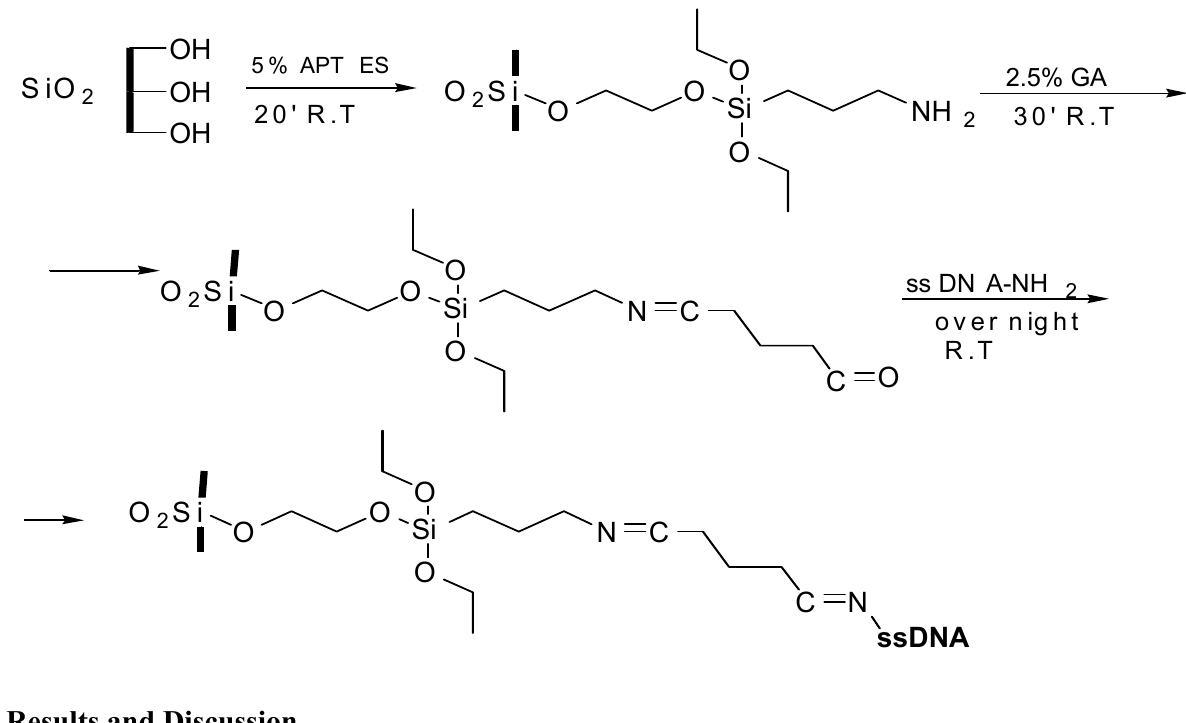
Figure 2. Schematic of the functionalization process, from the oxidized PSi chip to the covalent attachment of the DNA single